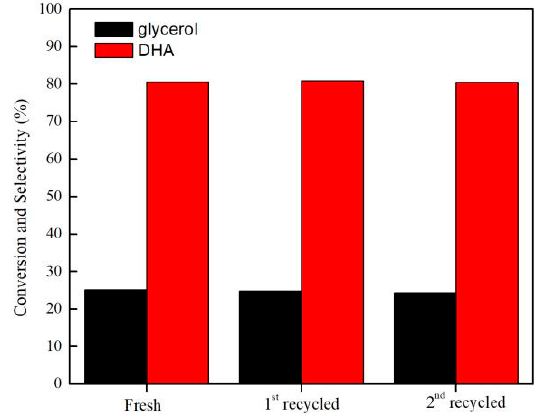
Figure 5. Recycling of Pt–7Bi/HT catalyst. Reaction condition: 0.1 g/mL glycerol aqueous solution 50 mL, Pt–7Bi/HT catalyst 0.5 g, reaction temperature 70 °C, reaction time 6 h, O 2 flow rate 150 mL/min.